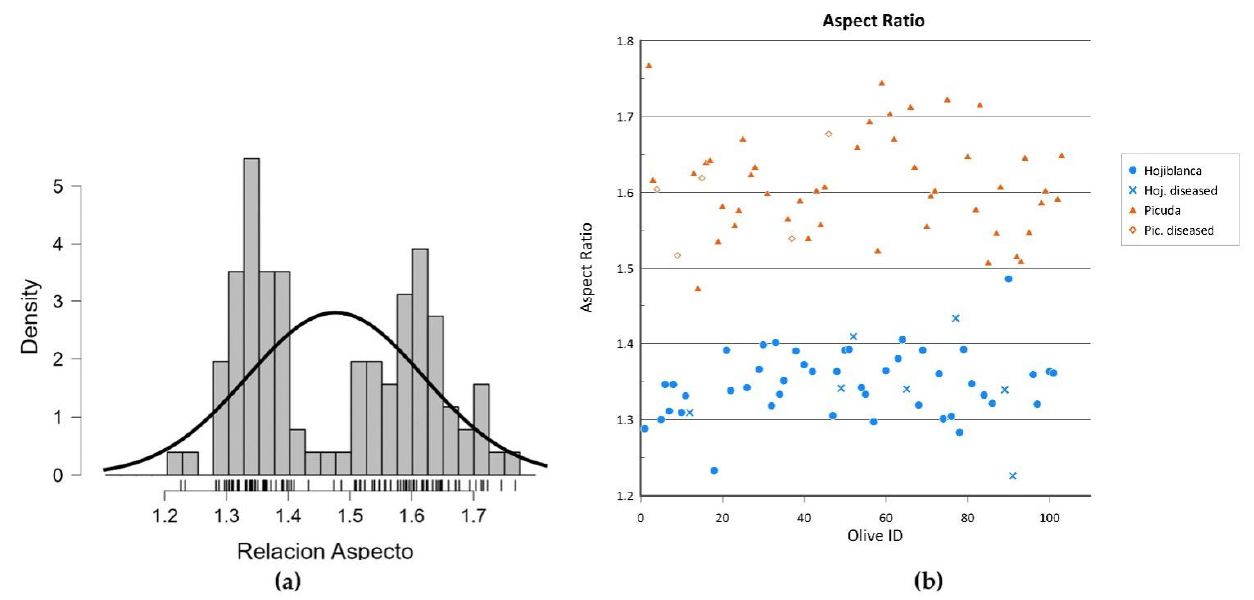
Figure 16. Aspect Ratio distribution: ( a ) histogram vs. theoretical probability density function (PDF), ( b ) scatter plot.